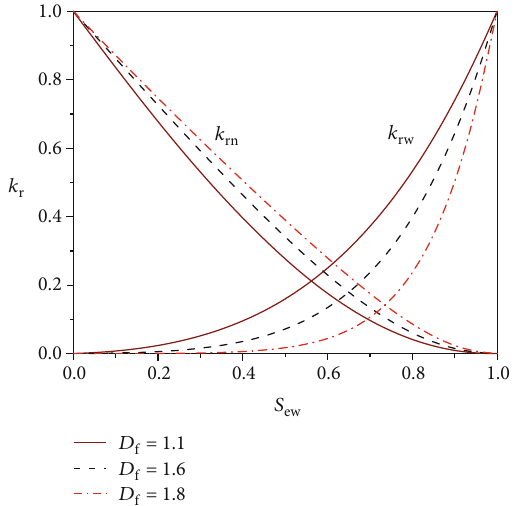
Figure 8: The e ff ect of the pore size distribution on relative permeability of porous media.